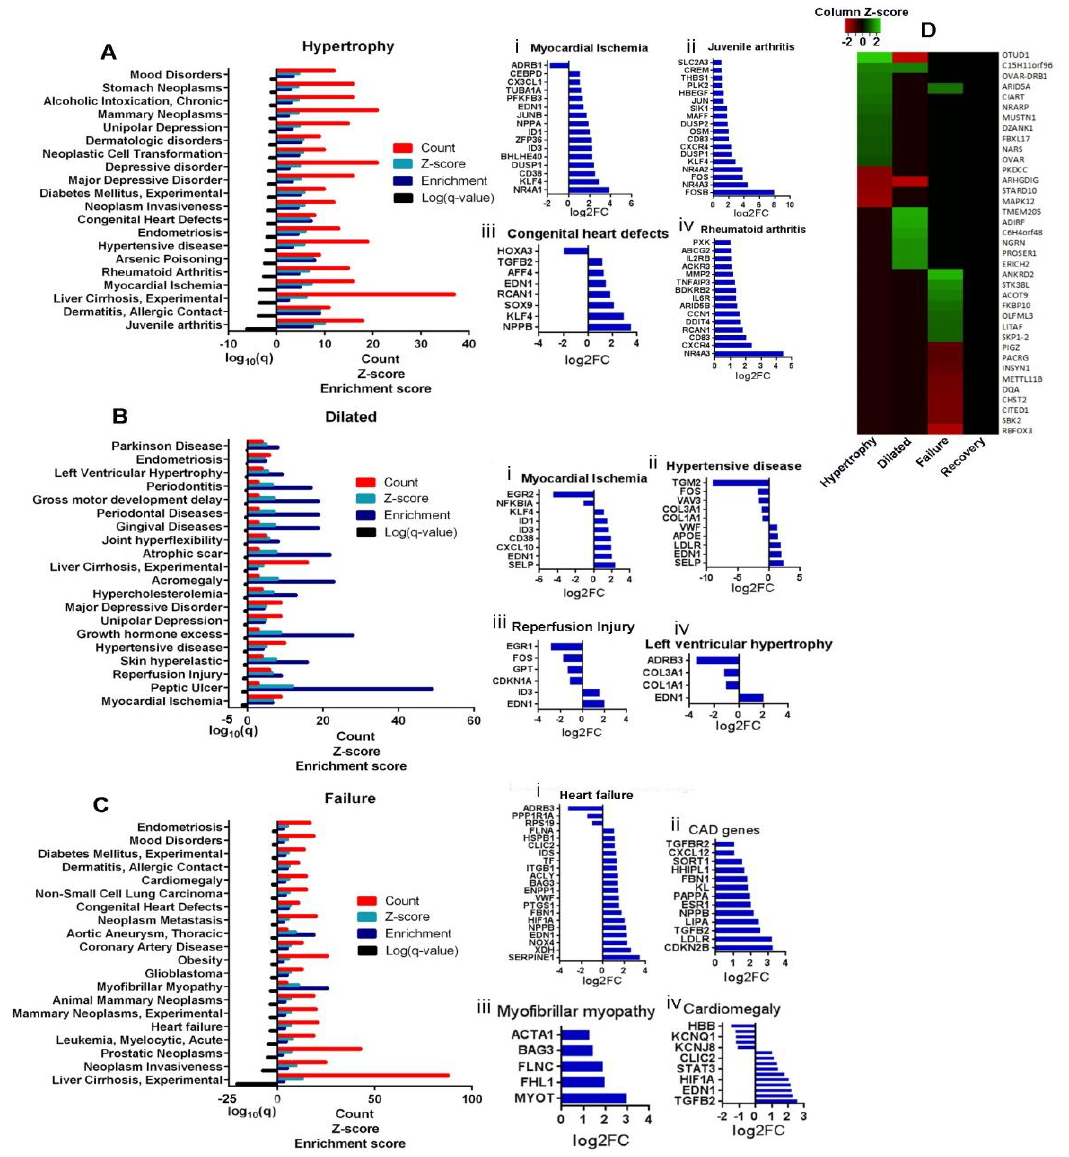
Figure 5. DisGeNET analysis for DEG–disease network identification. The DEGs in each stage were analysed for diseases enriched by them. ( A – C ) The graph denotes the significance log10(q) value, enrichment score, z-score, and the count of genes in the stage enriching the disease. ( A – C ) ( i – iv )) Subsets of graphs show the DEG-enriched selected diseases. ( D ) The potential candidate genes for cardiovascular diseases were filtered and depicted as a heatmap according to their fold change expression compared to the control.